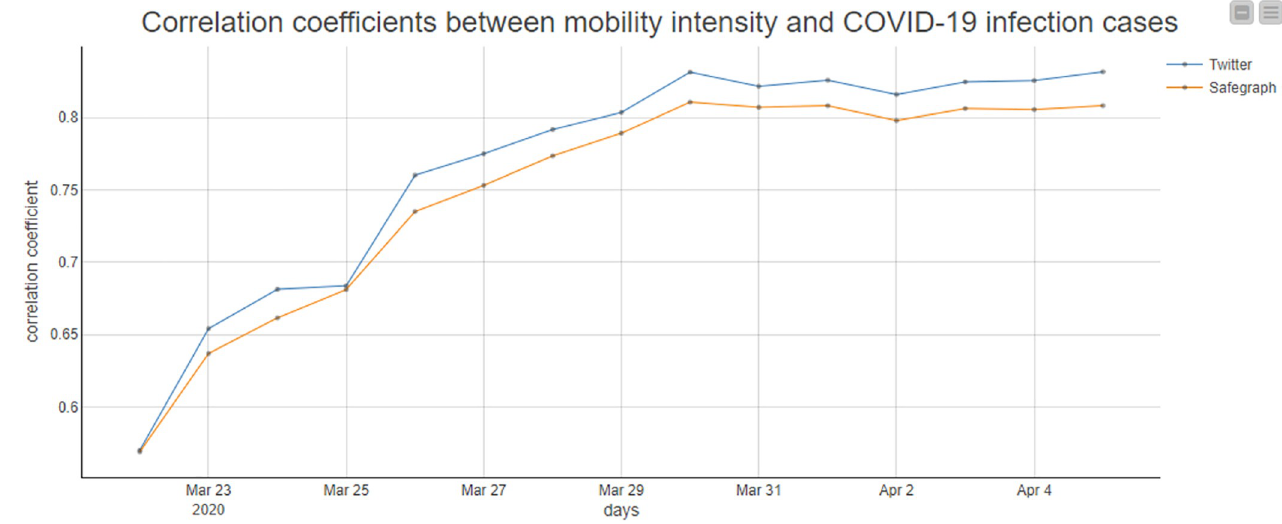
Fig 12. The correlation coefficients between outflows from New York and COVID-19 infection